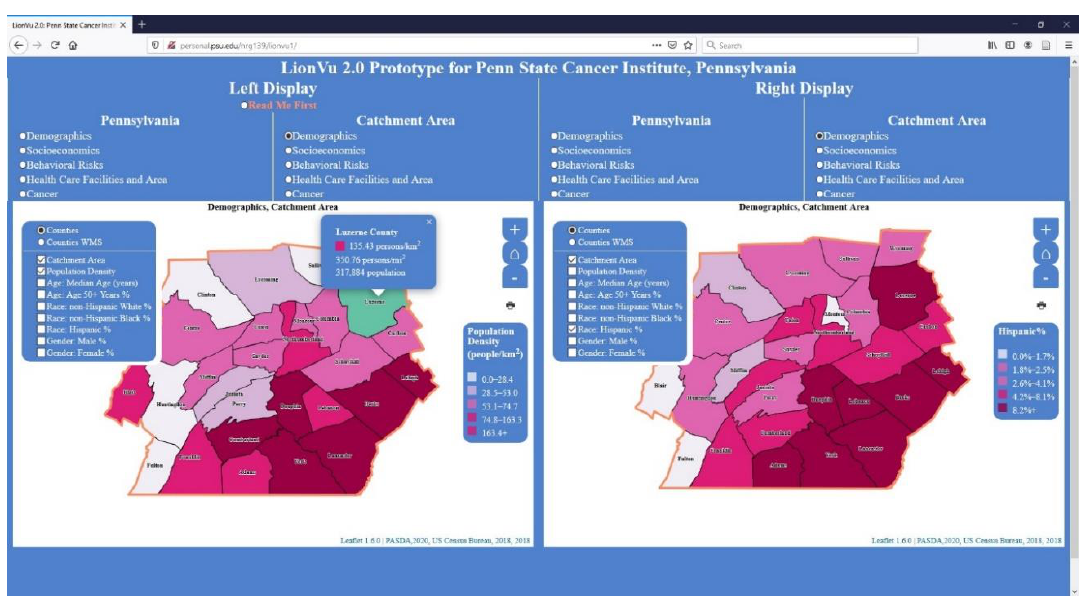
Figure 3. Screenshot of task 1. Left display: Population density (people/km 2 ) within catchment area. Right Display: Percent Hispanics residing within catchment area. Layer list was not collapsed in order to clarify what fields were available for selection.